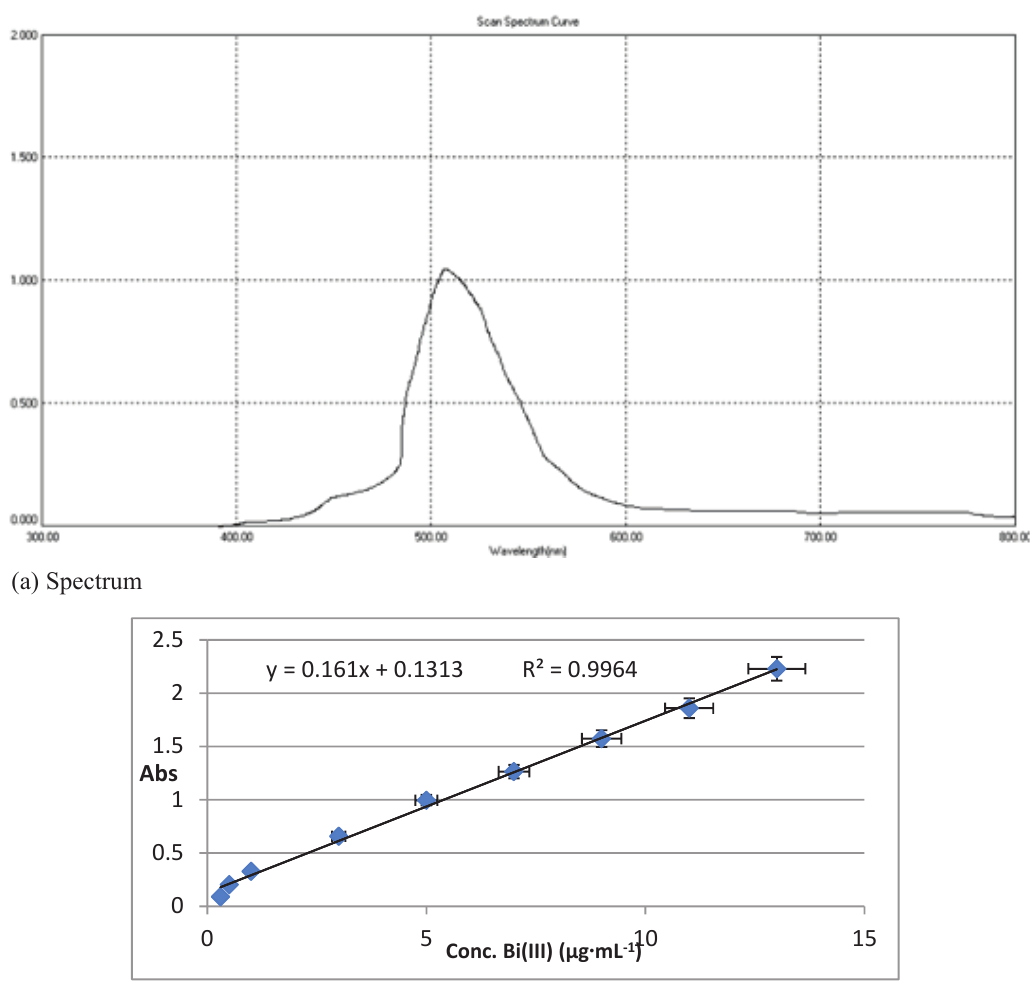
Figure 19: Absorption spectrum (a) and calibration curve for bismuth complex